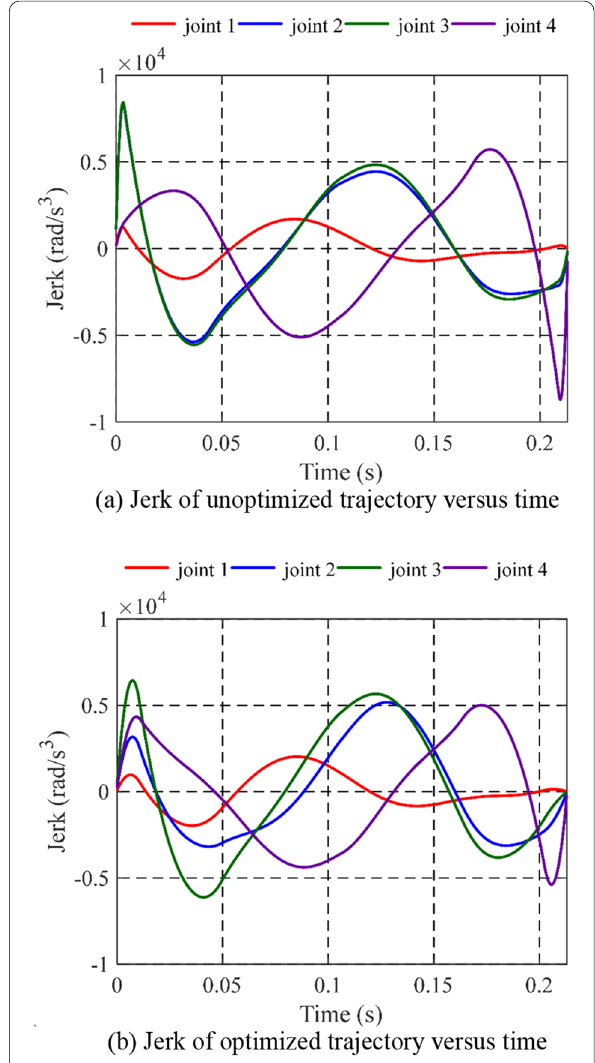
Figure 9 Jerk of unoptimized trajectory and optimized trajectory versus